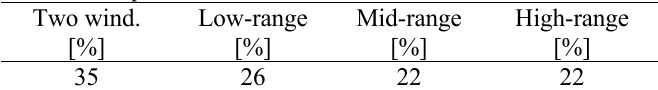
Table 9: The maximum errors of Mohan’s “monomial ex- pression”.